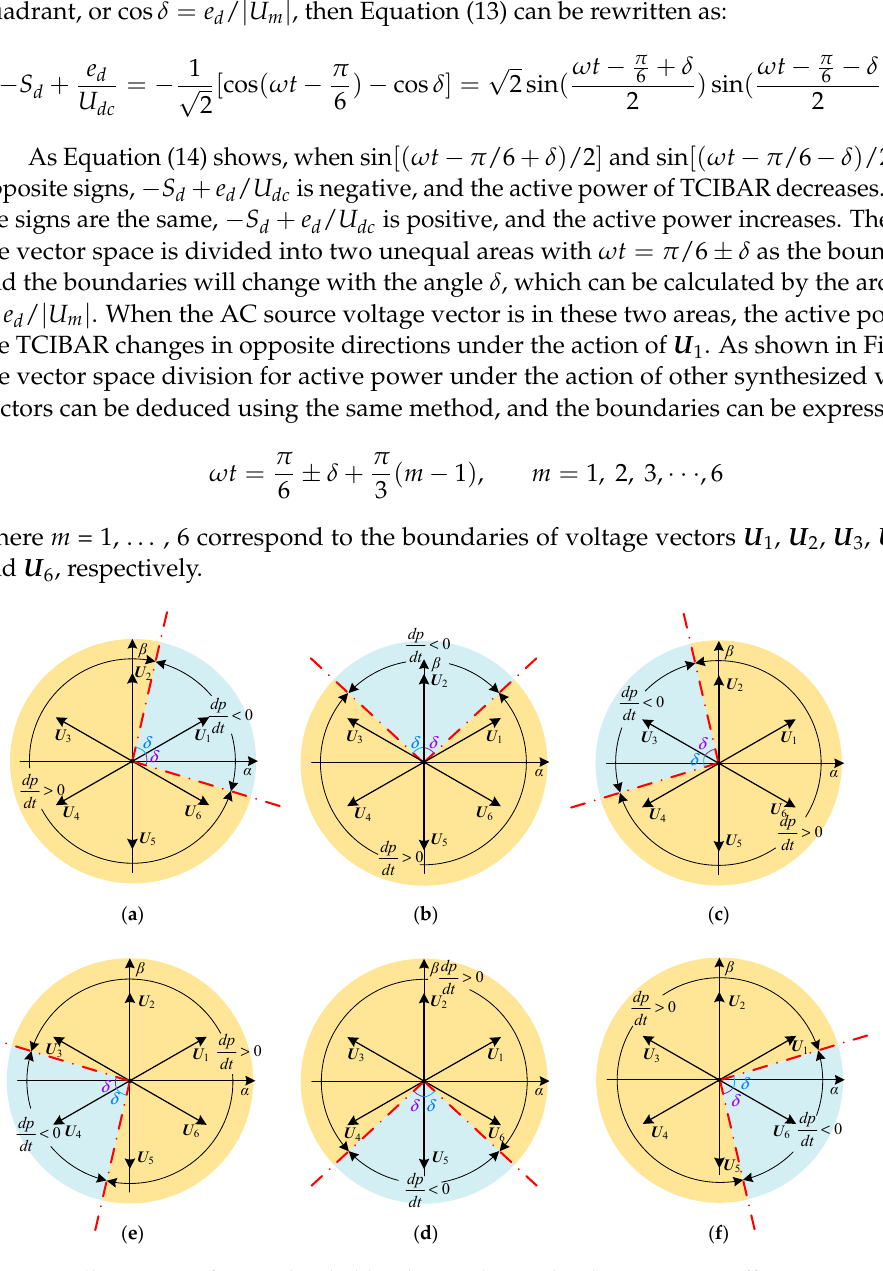
Figure 6. Vector space division for active power.